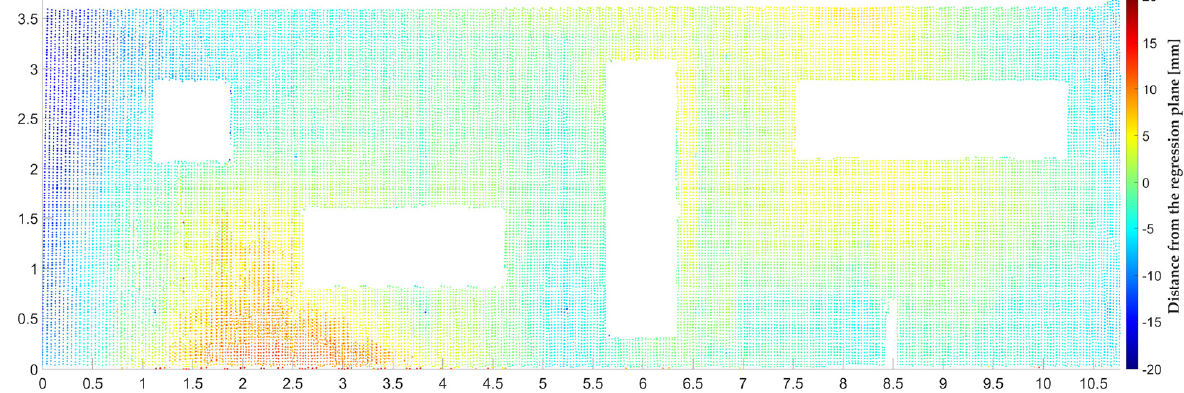
Figure 13. Comparison of the regression model and the segmented point cloud—wall no. 3.